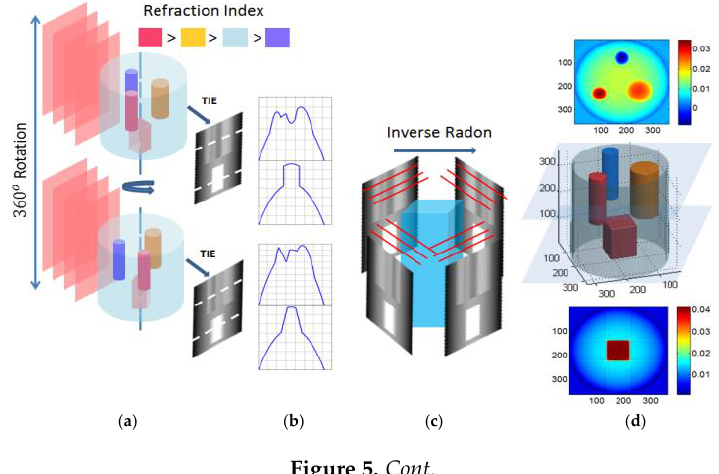
( e ) Figure 5. ( a ) Two different angular positions of rotation and simulated TIE phases; ( b ) Profiles corresponding to TIE phases; ( c ) application of IRT; ( d ) 3D reconstruction showing internal structure with different indices of refraction, and horizontal slice of internal structure; and ( e ) a screen capture of a 2D side view of the supplementary video showing the three cylinders and the cubic structure. 4. Experimental Results Using the SLM Based TIE 4 f Setup Consider the experimental 4 f TIE setup in Figure 2. First, a Gaussian illumination beam passes through a three-axis spatial filter (Model 900) with pinhole 25 µm. The beam is then collimated by a lens resulting in a plane wave before illuminating the object. Two lenses L 1 and L 2 (focal length f = f 1 = f 2 = 100 mm) are used in a 4 f configuration to image the object on the CCD camera. The monochrome CCD camera (Lumenera’s Lu100M series) has 1280 × 1024 pixels, with 5.2 µm pixel size, and with